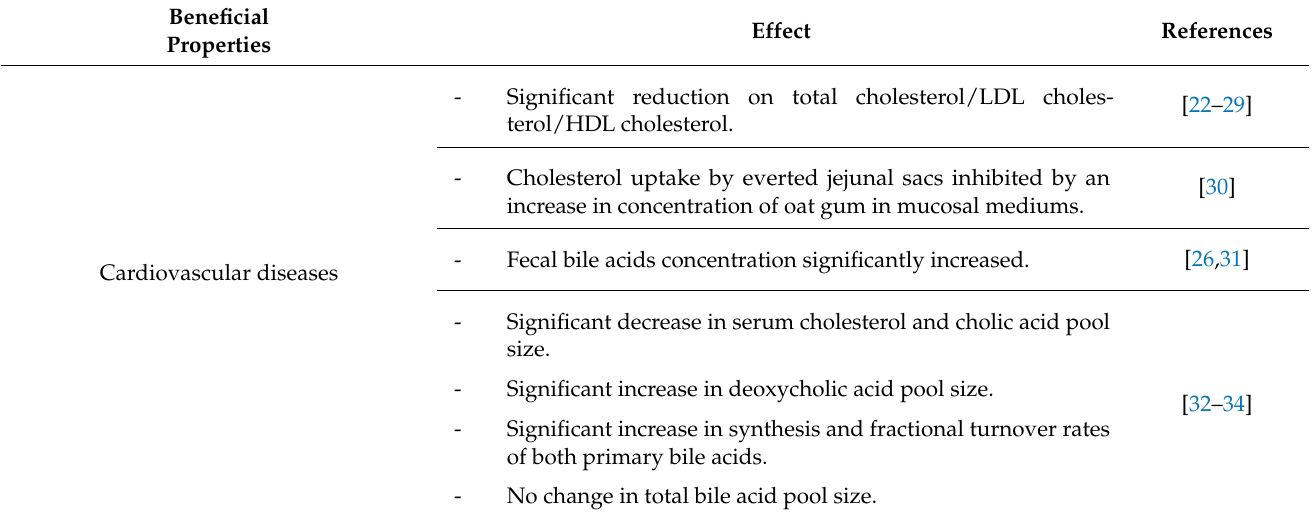
Table 1. Use of oat/oat products and their health beneficial